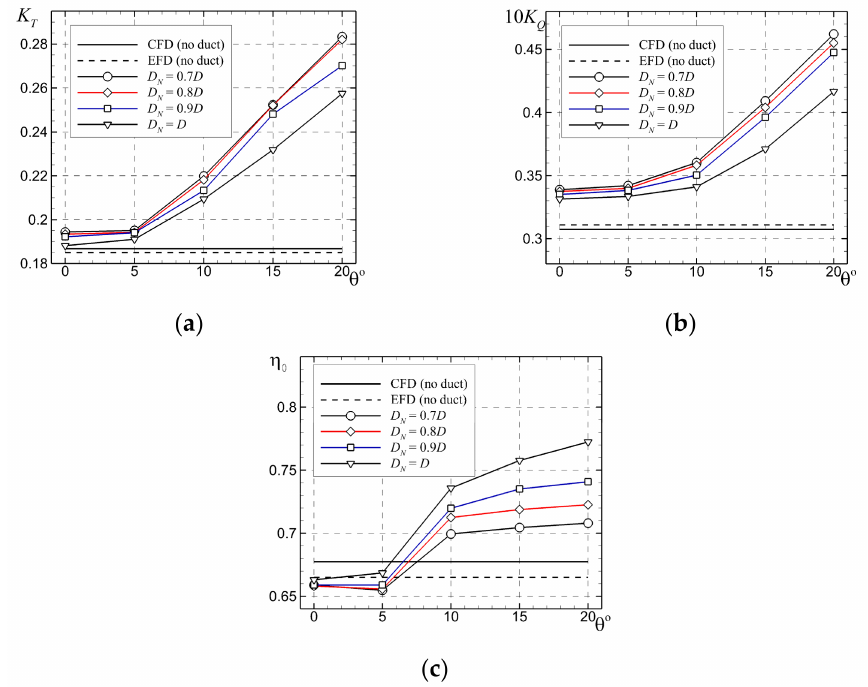
Figure 9. Force coefficients for different nozzles and the propeller only (without nozzle). ( a ) thrust coefficient, ( b ) torque coefficient, ( c ) open water